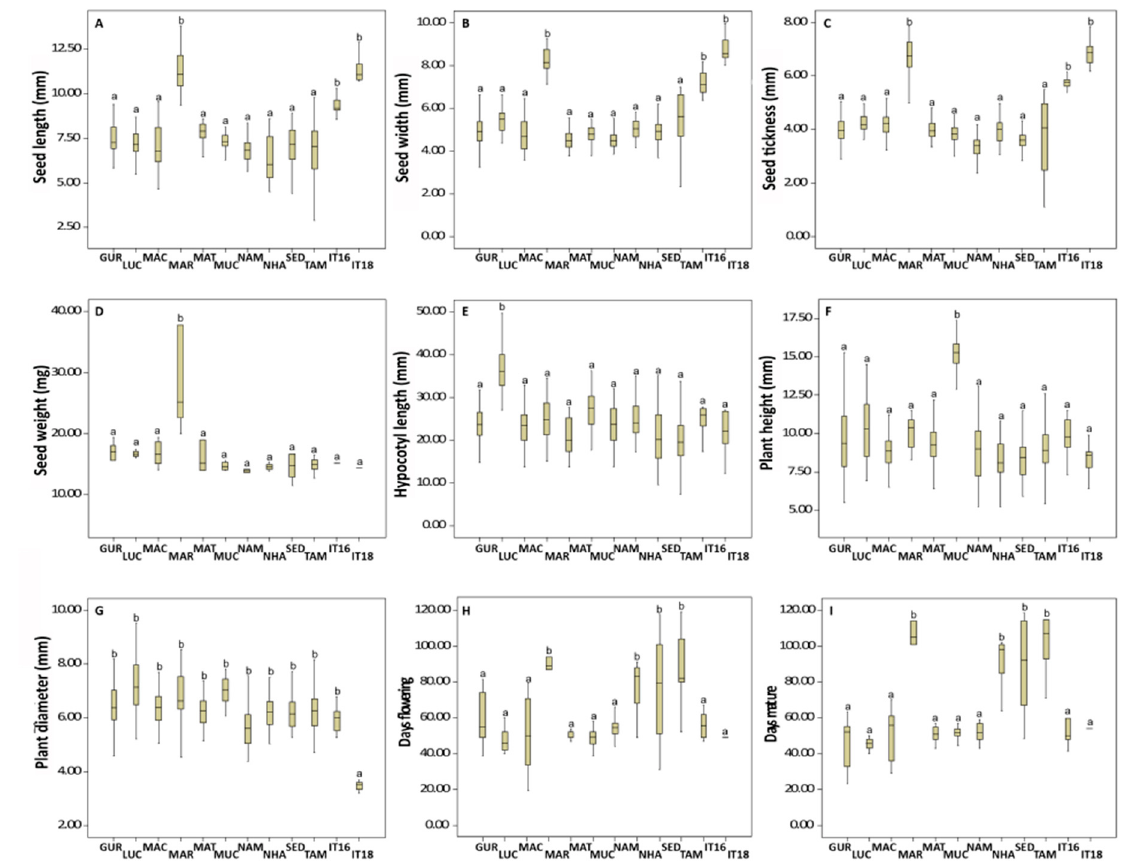
Figure 1. Box-and-whisker plots for the quantitative traits measured in the 610 analyzed specimens of Vigna unguiculata collected in 10 landraces, and the two commercial varieties. Names of landraces follow Table 1. Different letters indicate statistically significant differences between samples obtained by ANOVA followed by the post-hoc Scheffe test ( p < 0.05).